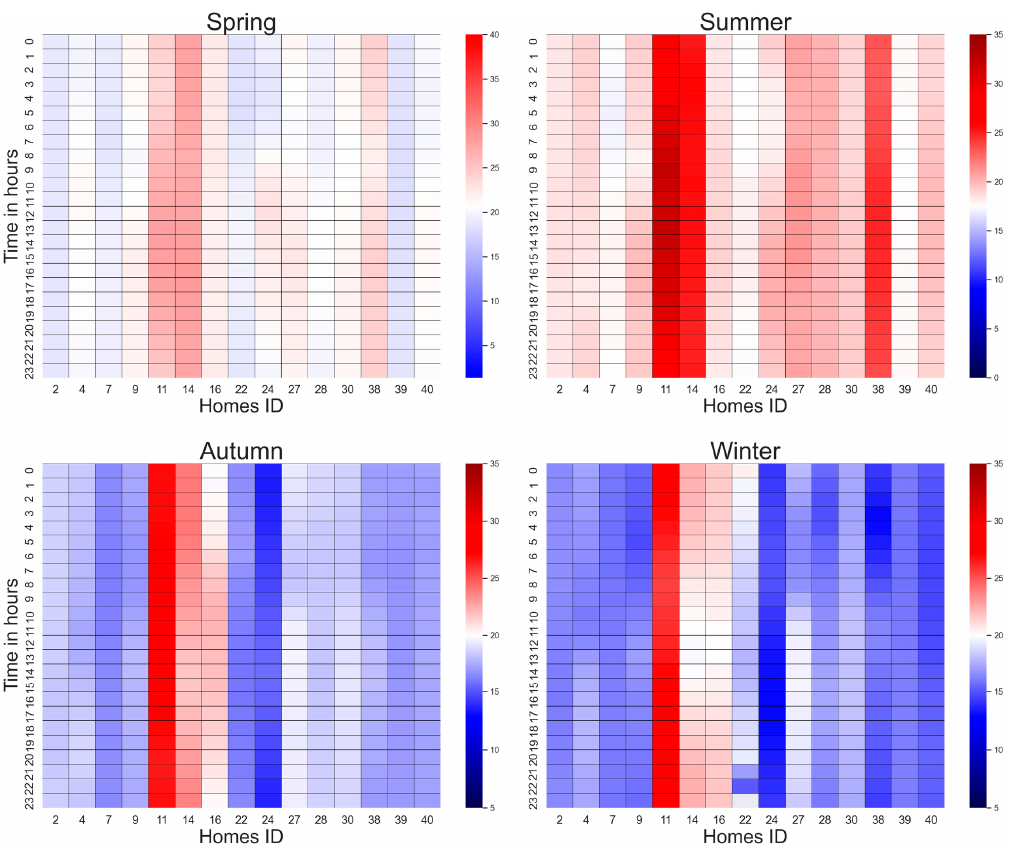
Figure 6. Heatmap of the average of each house’s seasonal living room temperatures across 2018 (spring, summer and autumn) and 2019 (winter).